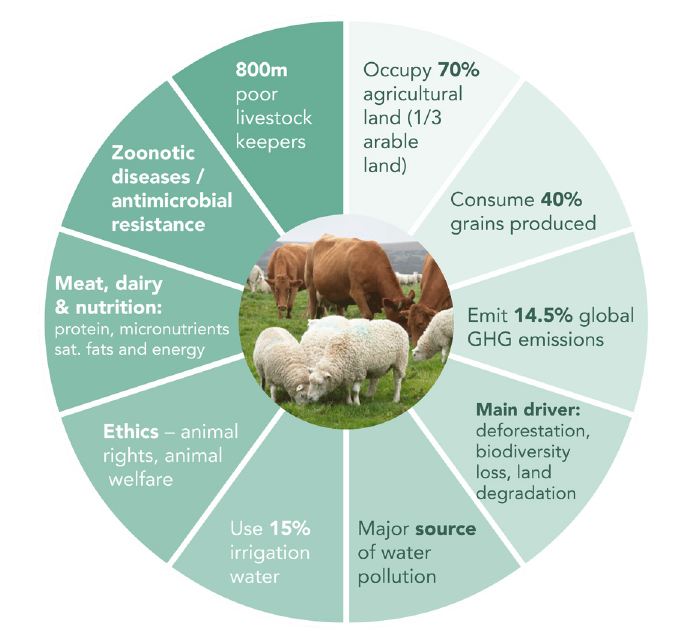
Figure 7: Livestock and animal products – a convergence of issues. Source: FCRN.